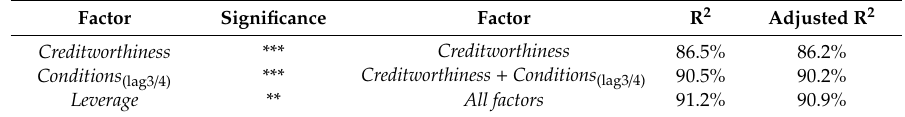
Table 1. Summary of US banks’ test regression results.